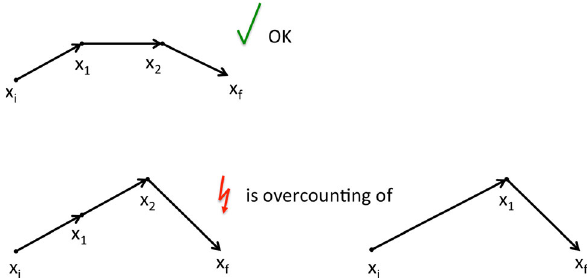
Fig. 1 Exemplification of possible overcounting of one path with two intermediate steps, which is already counted in the PI with one inter- mediate